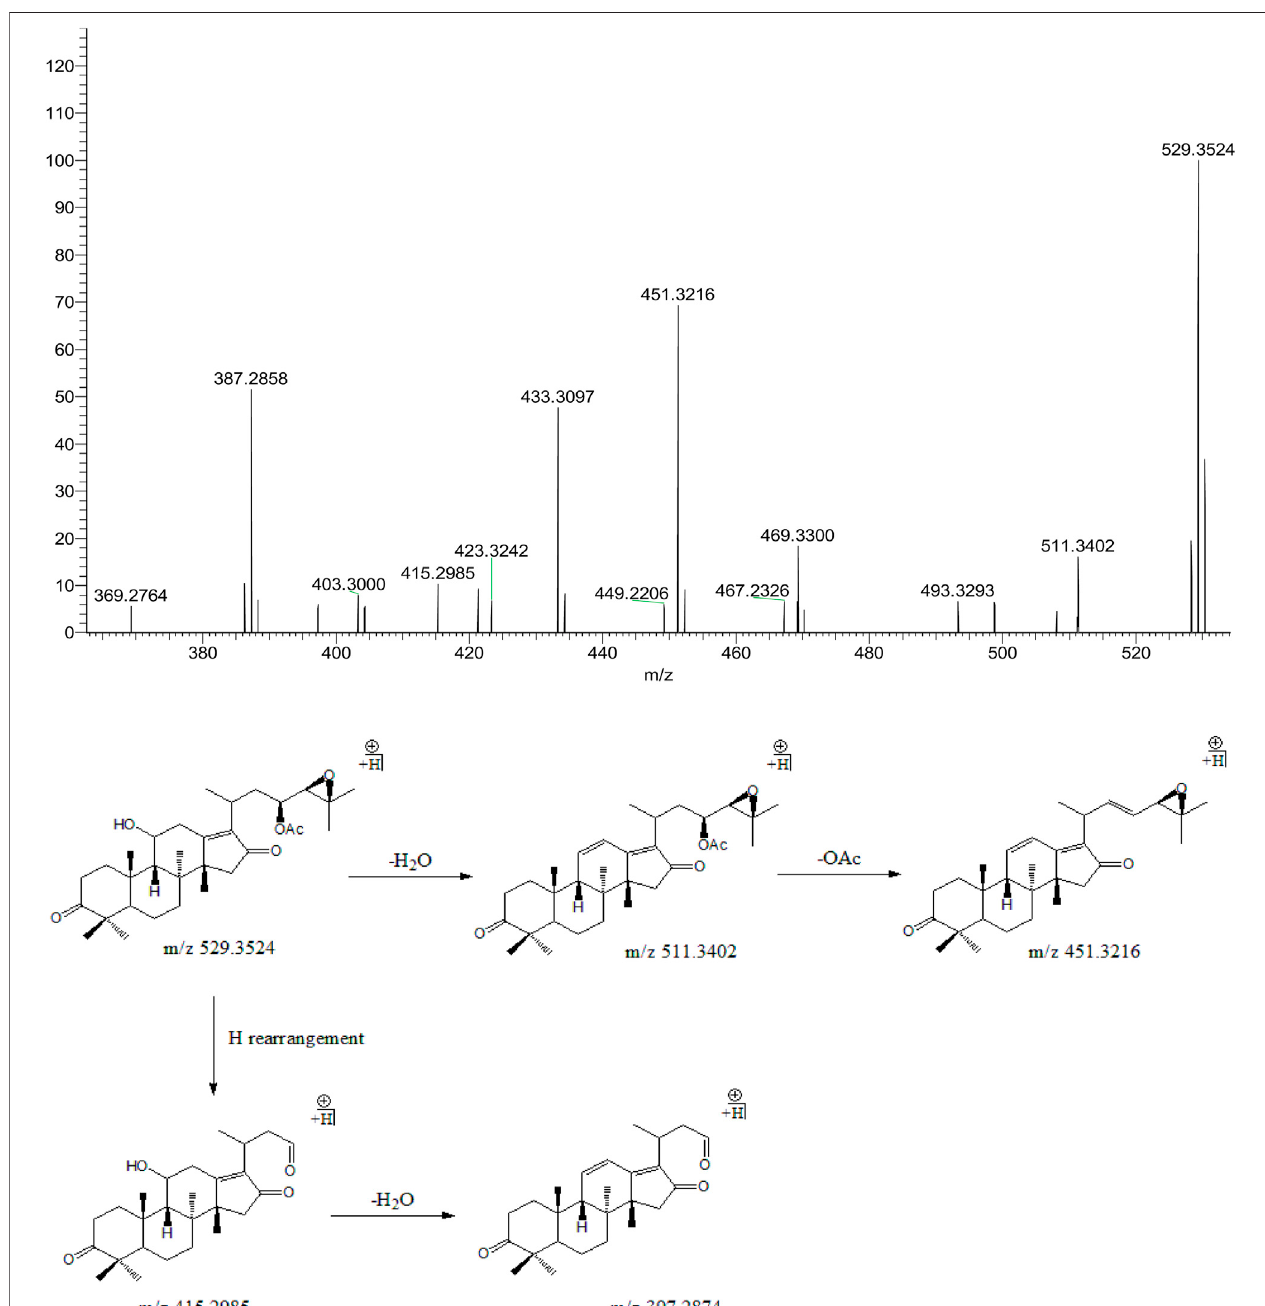
( Table 4 ; Supplementary Figures S1 – S6 ). The spiked recovery and matrix effect were determined from 90 – 110% ( Table 5